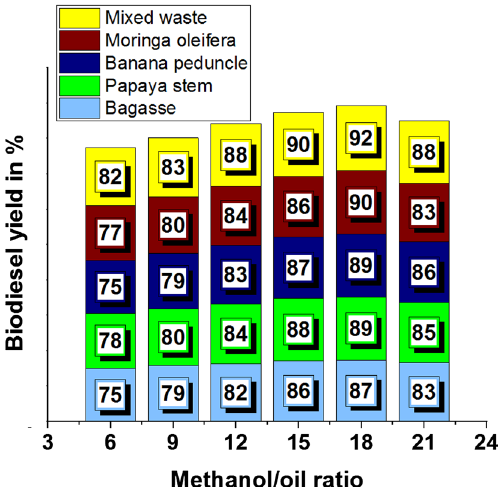
Figure 7. Comparison of biodiesel yield with different plant waste (methanol/oil ratio).